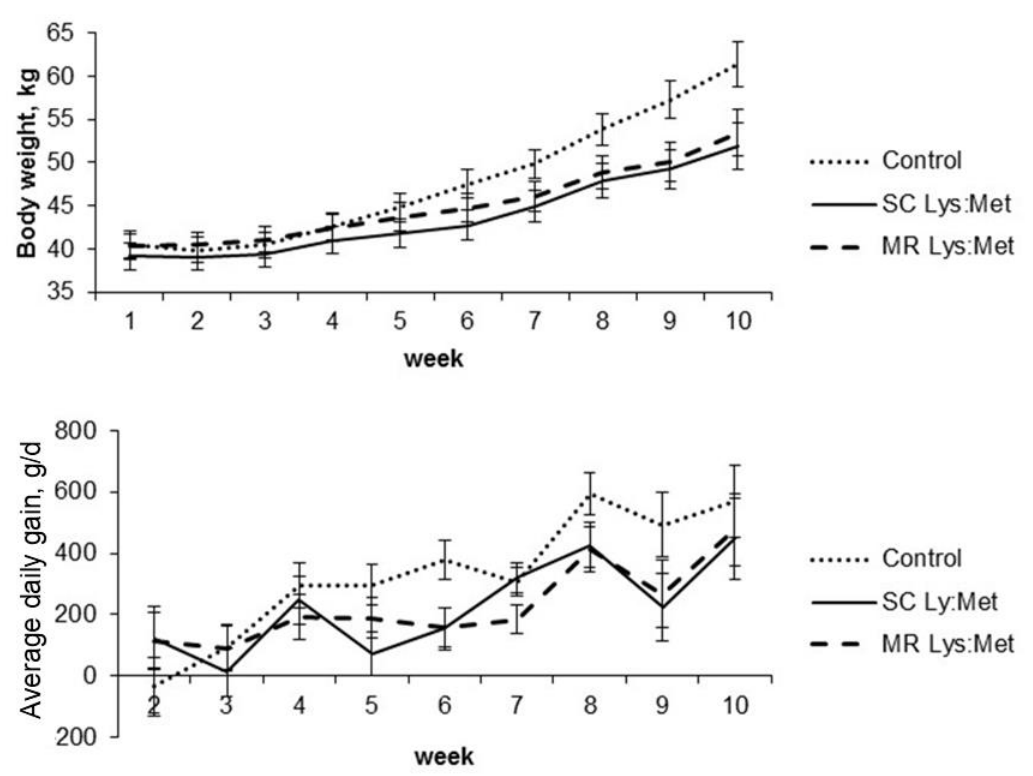
Figure 3. Body weight (kg) and average daily gain (g/d) of dairy calves with or without lysine and methionine supplementation in starter concentrate or milk replacer. Error bars indicate standard error of the mean.